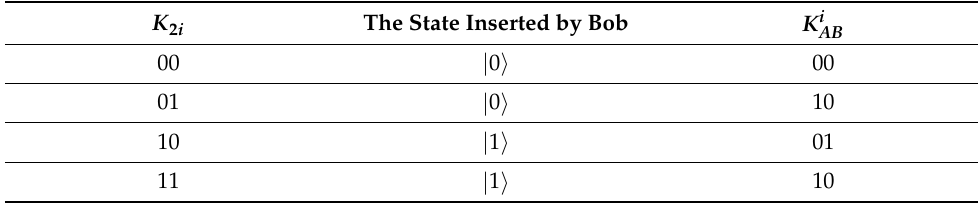
Table 1. Coding rule of K A B